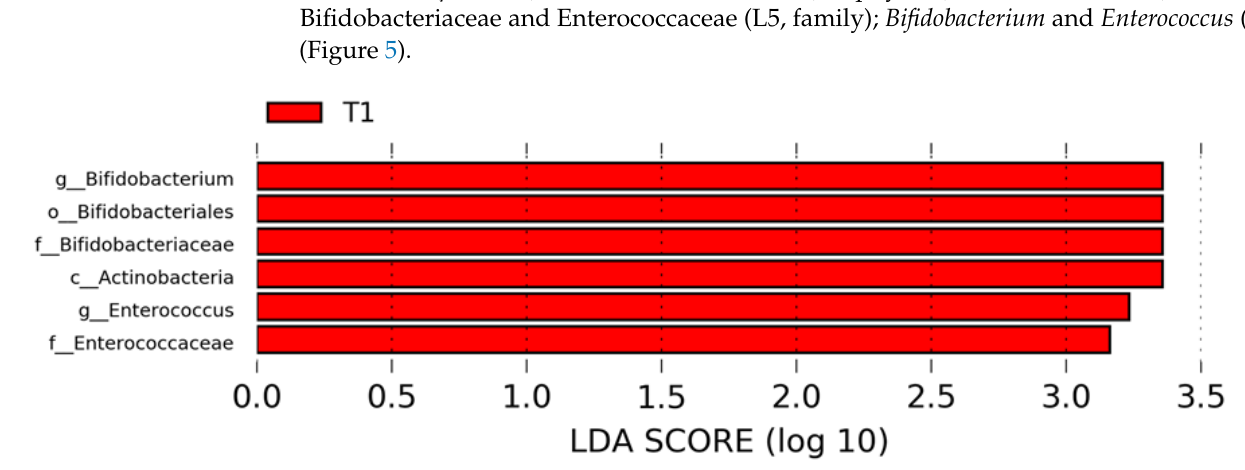
Figure 5. LEfSe analysis for high-dimensional biomarker discovery and explanation, based on linear discriminant analysis (LDA) effect size (LEfSe), employed to identify ASV features that resulted in statistical differences among T 0 and T 1 gut microbiota groups. Histogram represents the LDA scores until the taxonomy level genus (L6) filtered by statistical significance between the two groups. In red are represented microbial biomarkers for the patients at T 1 .